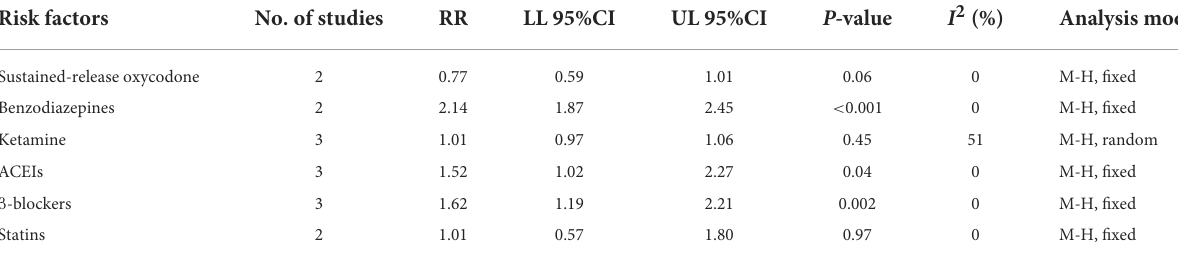
TABLE 6 The main outcomes of meta-analysis and subgroup analysis (drug factors). Risk